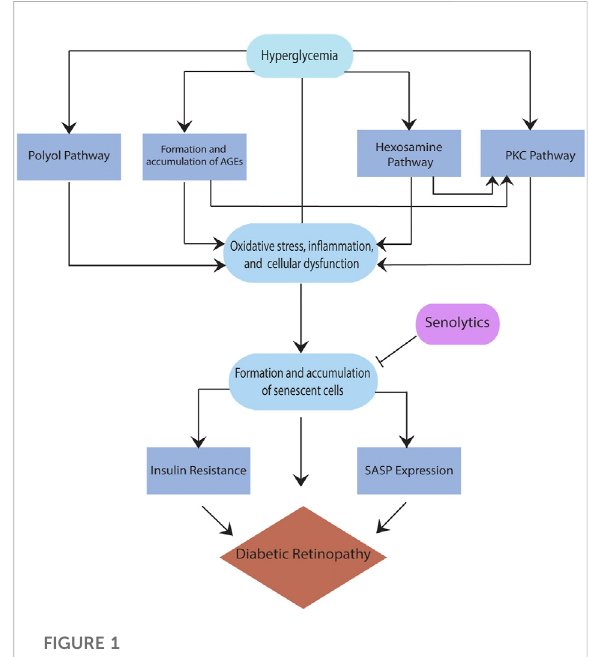
FIGURE 1 Schematic showing role of cellular senescence in diabetic